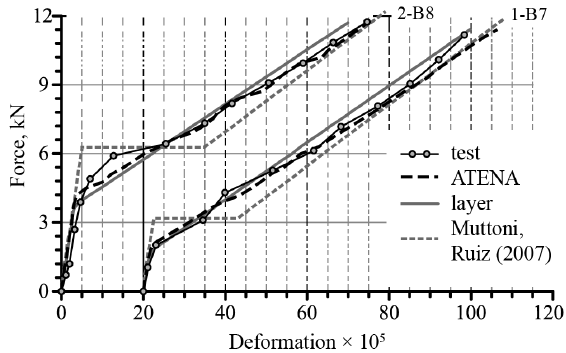
Fig. 6. Predicted deformations of the test